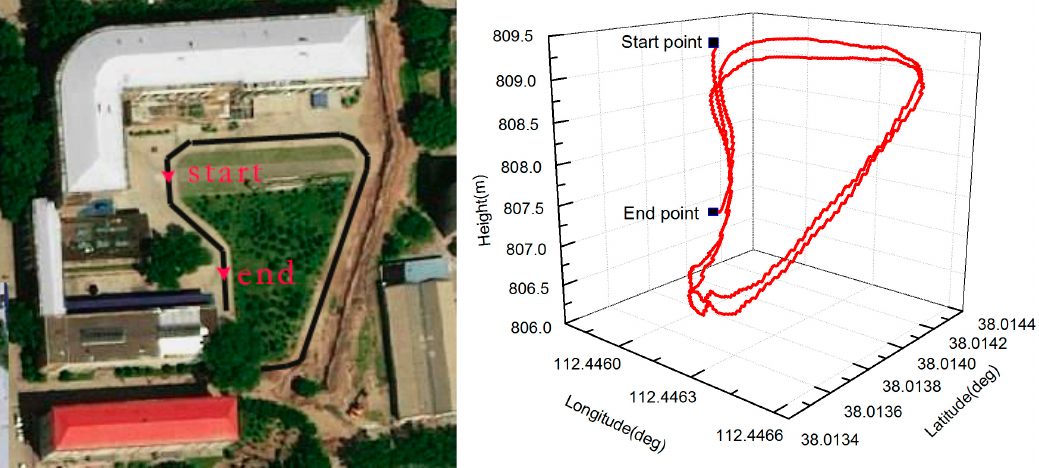
Figure 9. The reference trajectory of the vehicle. The two-dimensional reference trajectory of the vehicle ( Left ) and the corresponding three-dimensional trajectory ( Right ).